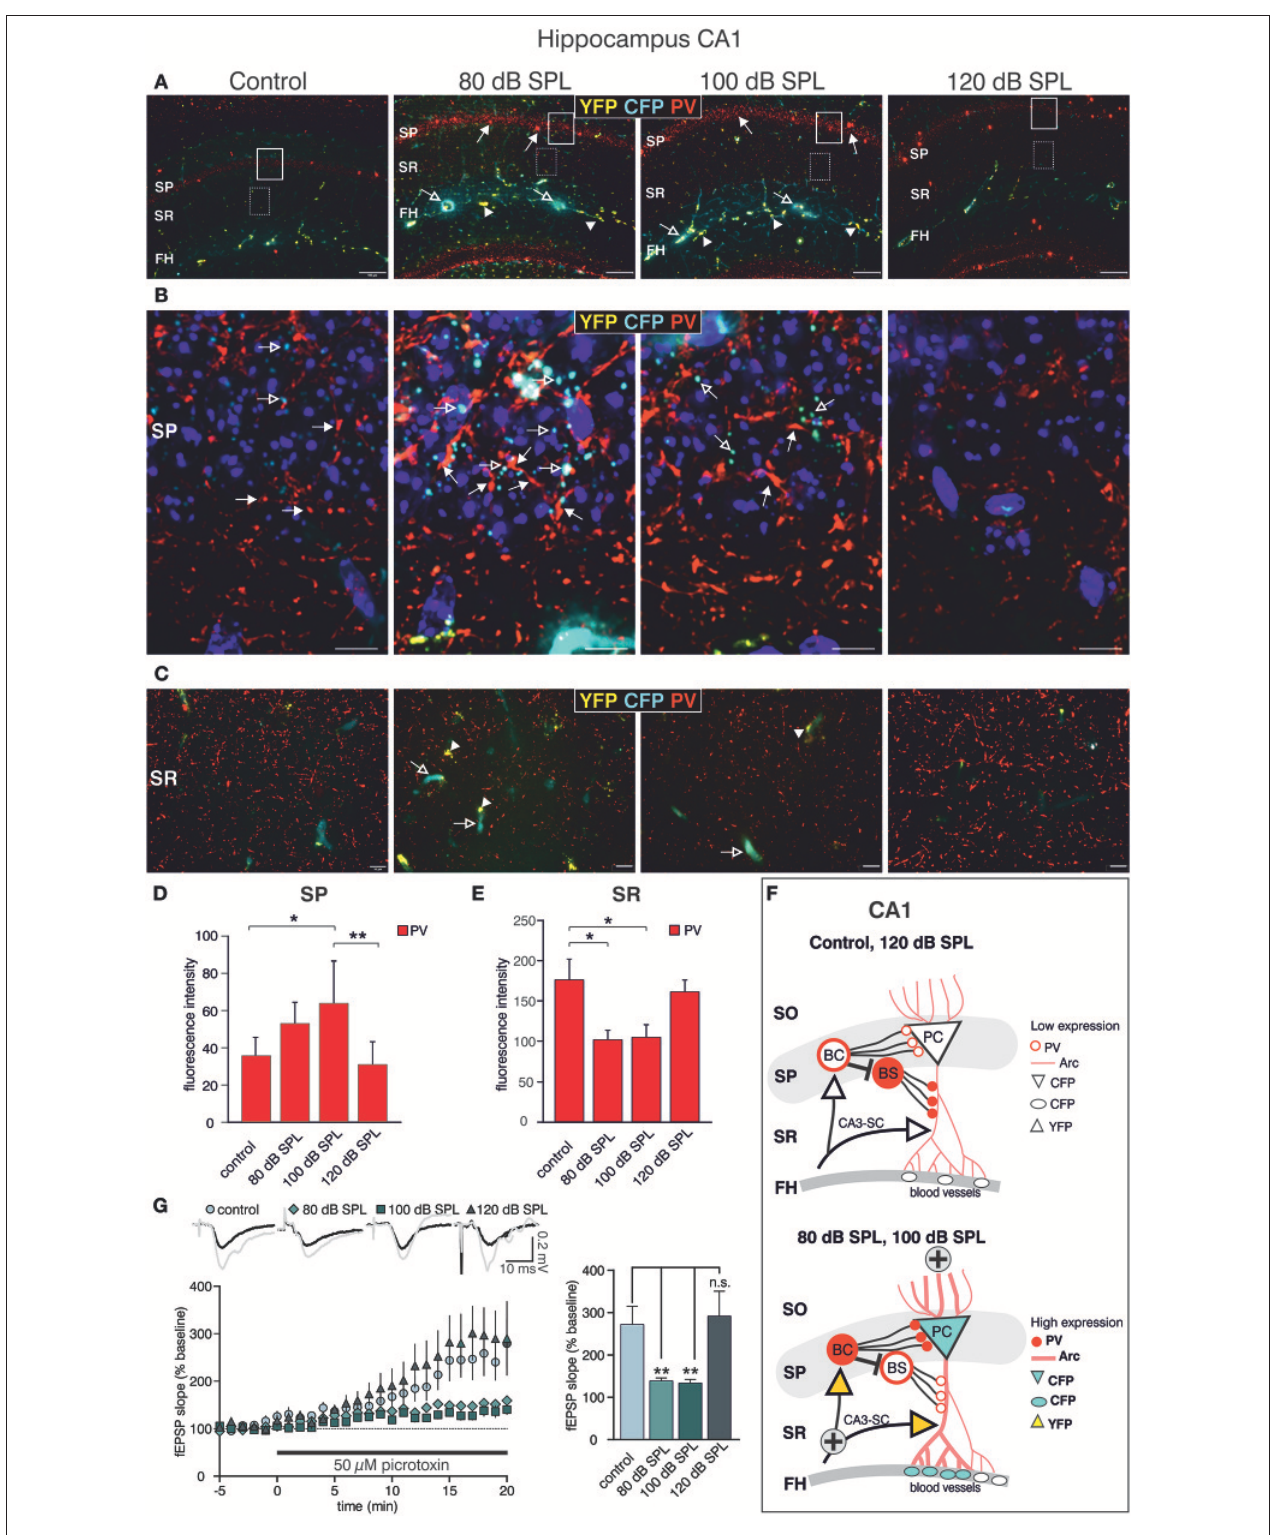
FIGURE 6 | Dynamic changes of Bdnf exon-IV and -VI transcripts and parvalbumin after sound exposure in the hippocampal CA1 region. (A) Low-magnification of parvalbumin (PV) IR in BLEV reporter mice 2 weeks after exposure to control, 80, 100, or 120 dB SPL. Note the up-regulation of PV IR (arrows) in the SP